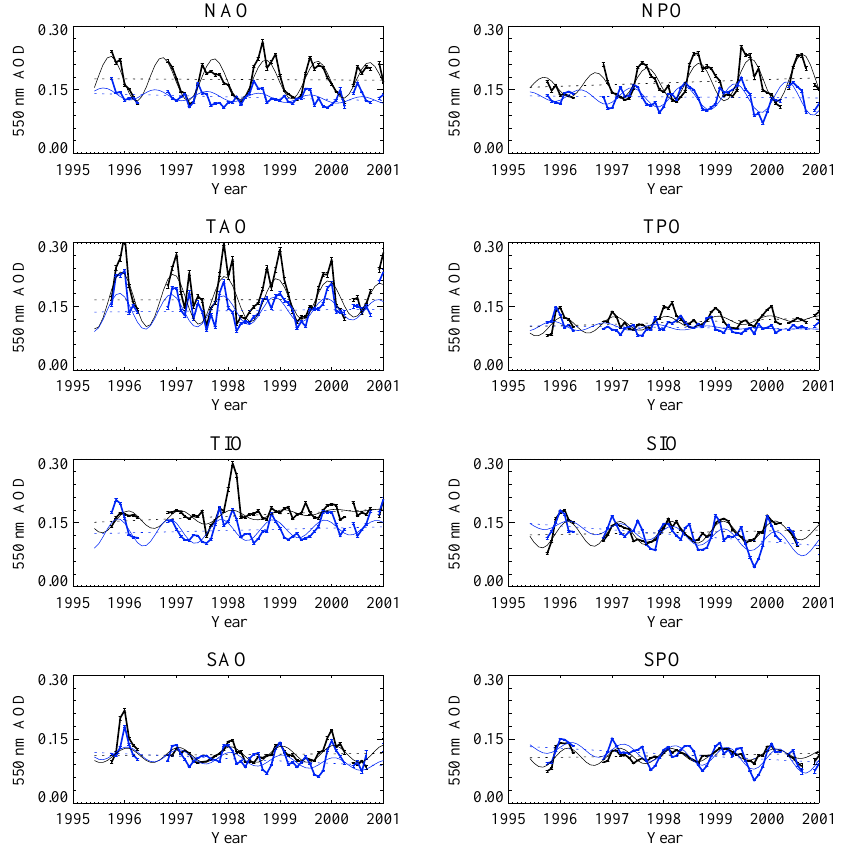
Fig. 9. Regional times series comparison of GRAPE and GACP AOD. Monthly averaged data are given by the thick-solid lines, with GRAPE in black and GACP in blue. Fits to the time-series using Eq. (5) are given by the thin solid lines, and the linear component of these fits are shown by the dotted lines.